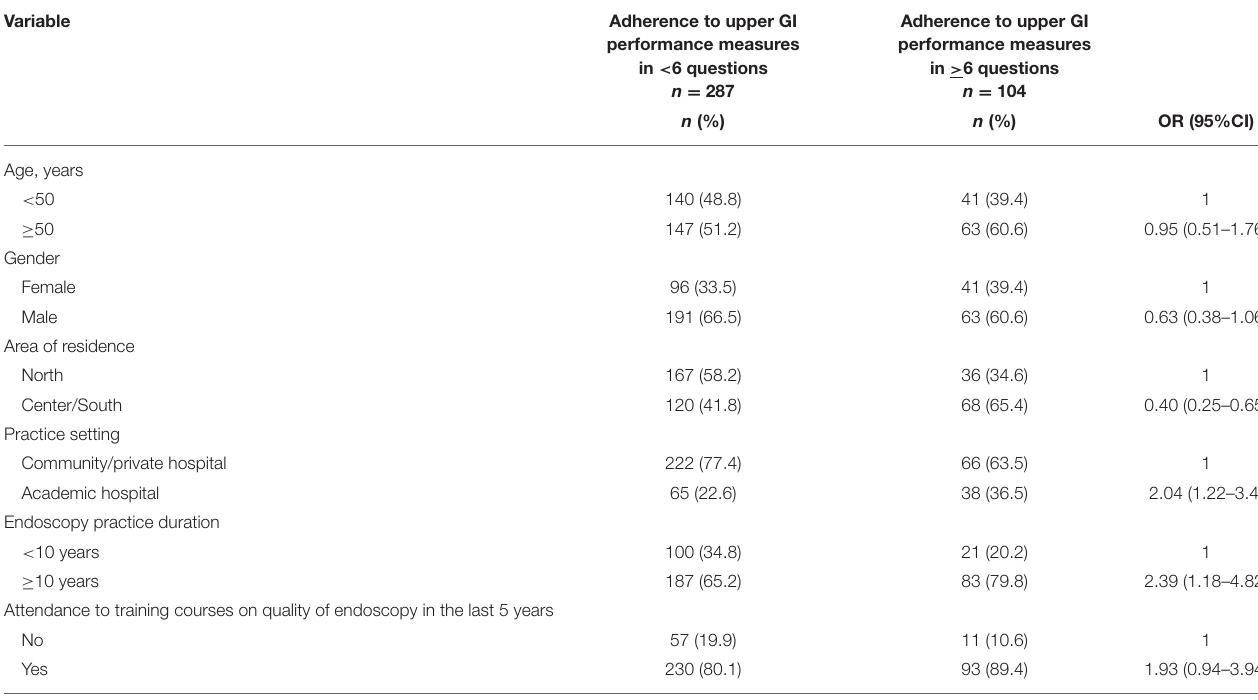
TABLE 4 | Predictors of adherence to performance measures for upper gastrointestinal endoscopy in at least 6 out of 8 questions (respondents n = 391). Variable